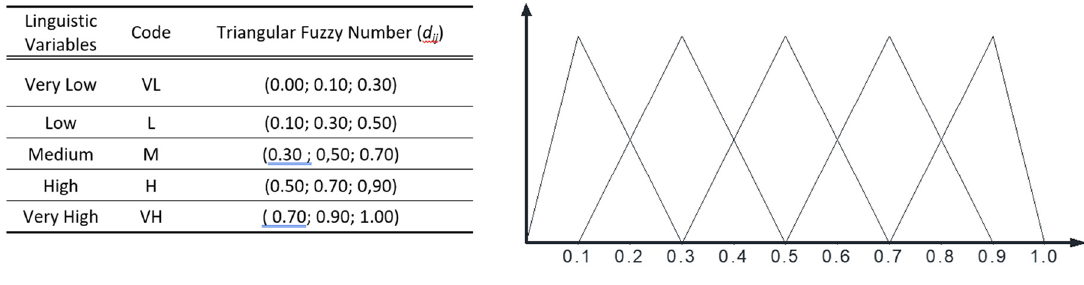
Figure 1. Linguistic variables on triangular